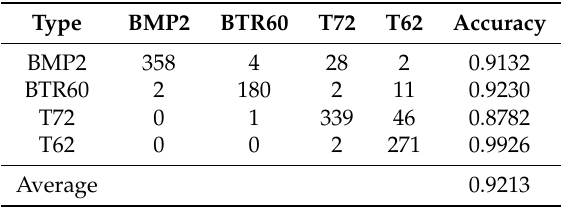
Table 6. The training and testing samples in the configuration variance EOC-1